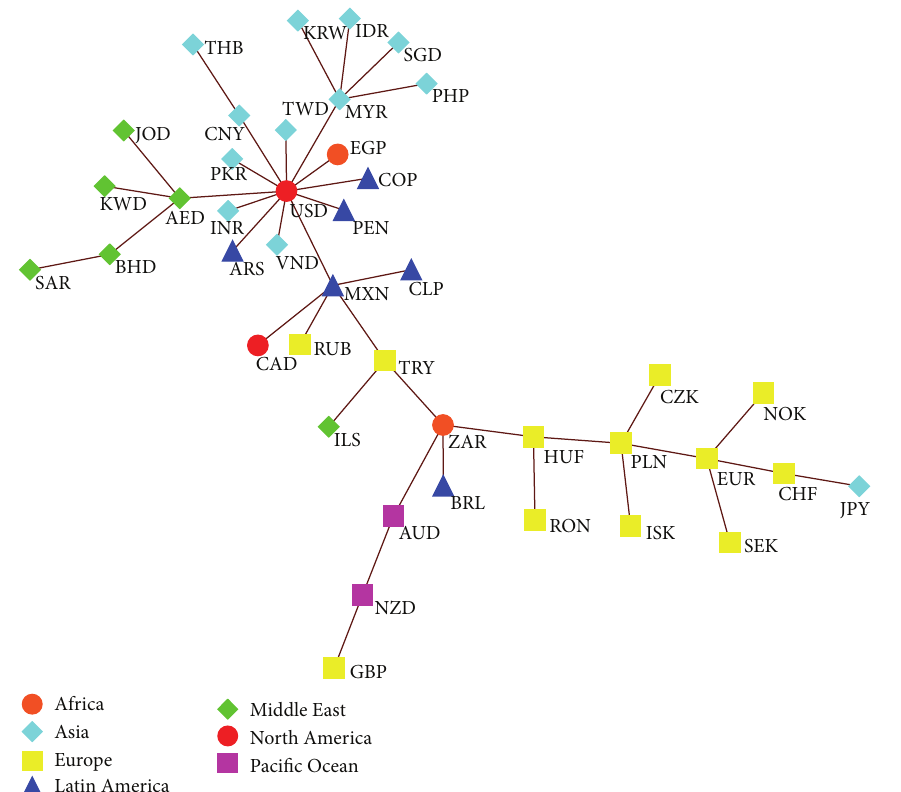
Figure 4: MST of 42 currencies in the international FX market on January 2, 2008, as a representative of the period of during financial